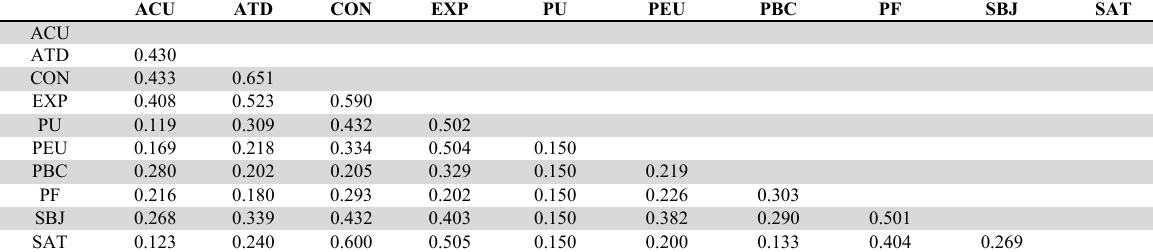
Heterotrait-Monotrait ratio (HTMT)